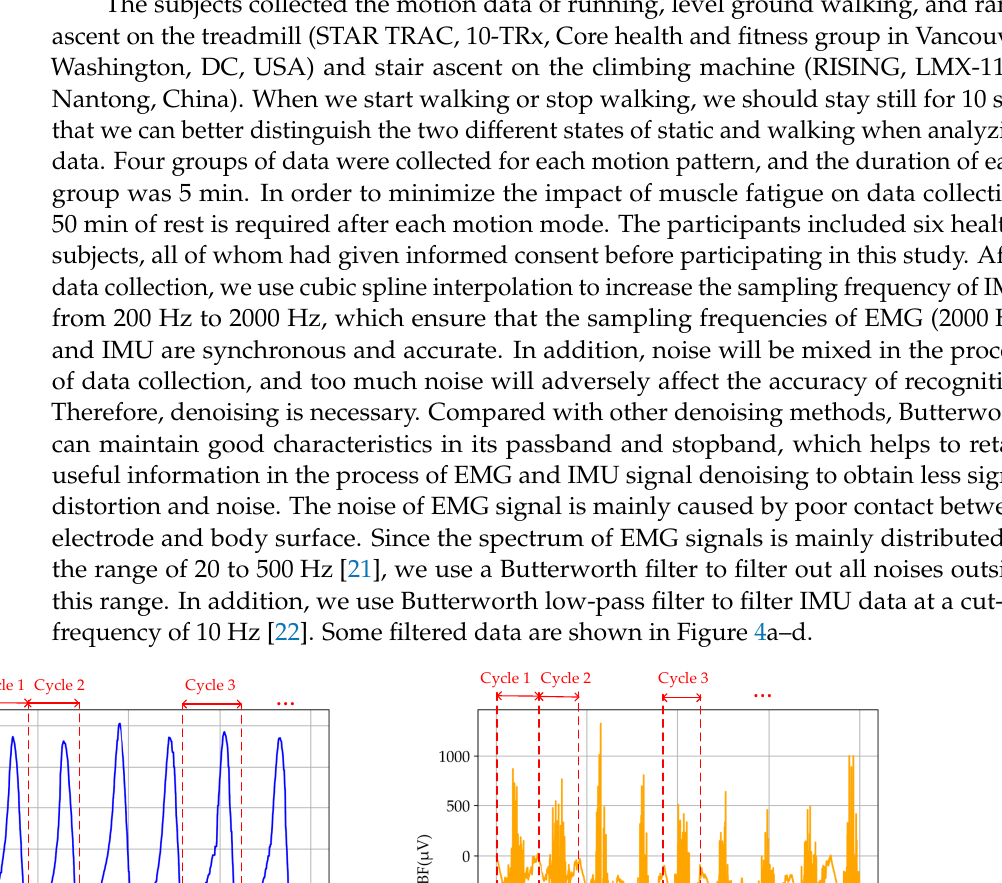
Figure 3. Four daily patterns of human movement. ( a – d ) represent running, level ground walking, stair ascent and ramp ascent.